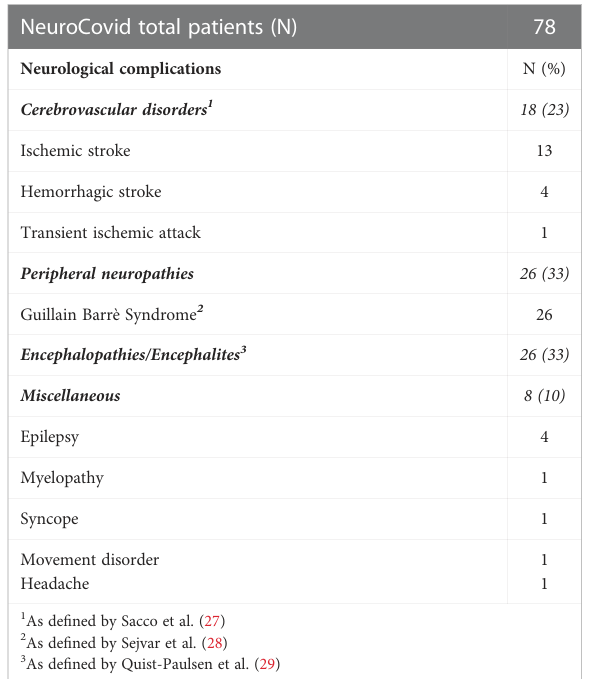
TABLE 2 Case de fi nition for NeuroCovid